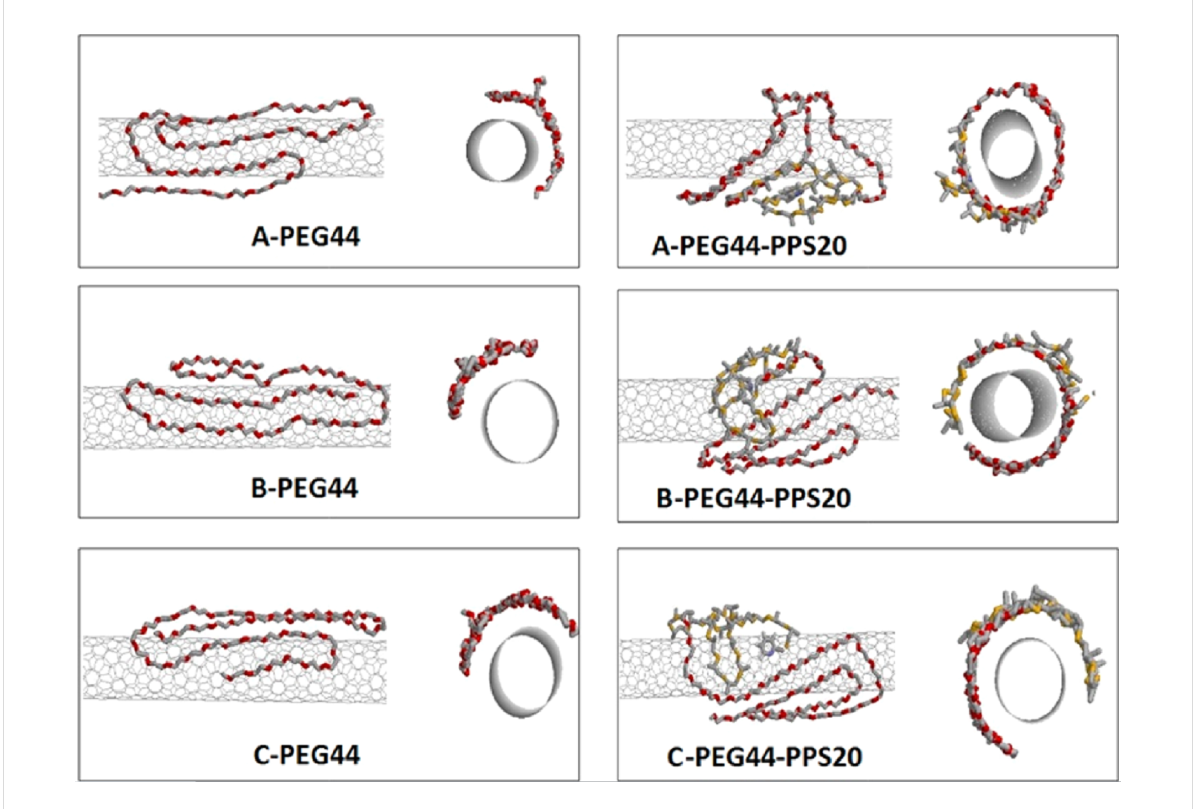
Figure 4: Representative structures of poly(ethylene glycol), PEG 44 , and poly(ethylene glycol- bl -propylene sulfide), PEG 44 − PPS 20 , adsorbed on SWCNT as obtained by essential dynamics analysis. The presence of PPS (see structures on the right) enables the block copolymer chain to fully wrap the CNT thus minimizing nanotube − nanotube aggregating interactions. Reprinted with permission from [71]. Copyright 2012, American Chem- ical